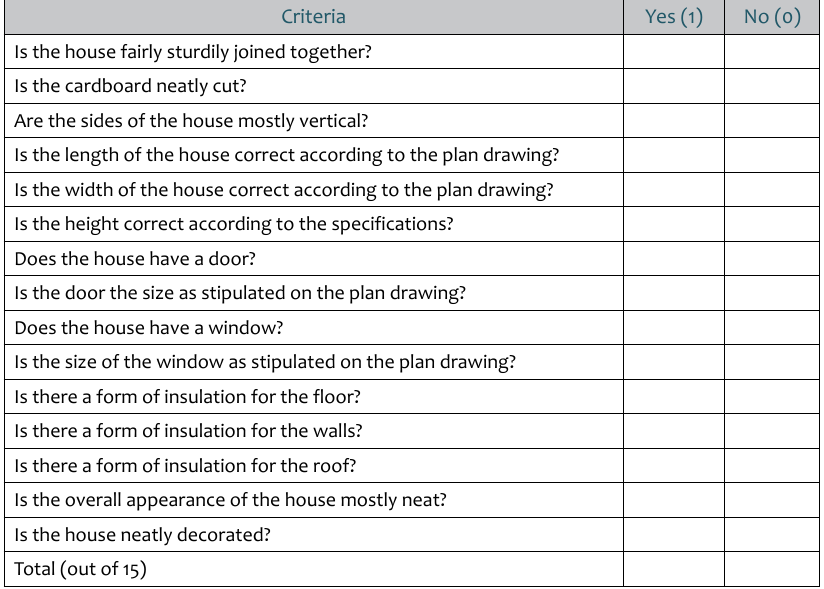
Table 2: Checklist for the assessment of the group work mouse house